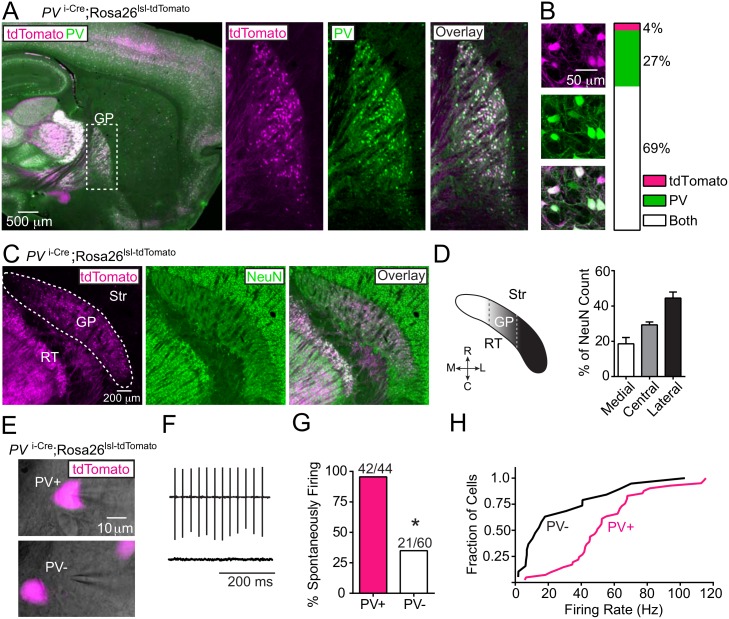
Parvalbumin (PV) expression defines a physiologically distinct cell type in the GP.(A) Left, sagittal brain section from a PV
i-Cre;Rosa26tdTomato mouse where Cre expression is reported by tdTomato (magenta) followed by immunolabeling for PV (green). Right, high magnification of boxed area containing the GP. (B) Quantification of co-localization between tdTomato (magenta) and immunolabeled PV (green) in the GP using confocal microscopy. Left, a single confocal plane. Right, summary graph of co-localization results (n = 24/679 cells tdTomato+ only; n = 184/679 cells PV+ only; n = 471/679 cells double-positive, from 2 mice). (C) Horizontal section of PV
i-Cre;Rosa26tdTomato mouse where Cre expression is reported by tdTomato (magenta) followed by immunolabeling for NeuN (green). (D) Quantification of the percentage of NeuN+ neurons with tdTomato reporter expression along the medial-lateral axis of the GP. Left, schematic of GP in the horizontal plane. Dashed lines delineate approximate groupings of medial, central and lateral sagittal sections. RT, reticular nucleus of the thalamus. Right, summary graph of mean tdTomato/NeuN percent co-localization based on sagittal sections (from 3 mice, 3 replicates/mouse). Error bars denote s.e.m. (E) Acute sagittal slice of PV
i-Cre;Rosa26tdTomato mouse brain showing cell-attached recordings from tdTomato+ and tdTomato- GP neurons. DIC image (gray) overlaid with tdTomato fluorescence (magenta). (F) Example cell-attached recordings showing action current deflections indicative of spontaneously active (top) and non-spontaneously active (bottom) GP neurons. (G) Summary graph showing the percent tdTomato+ and tdTomato- GP neurons exhibiting cell-attached spontaneous activity (n = 29/30 PV+, n = 15/41 PV- cells; from 3 mice). Asterisk, P<0.05 (Fisher’s Exact test). (H) Cumulative frequency distribution plot of firing rates from spontaneously active tdTomato+ and tdTomato- GP neurons. Active tdTomato+ exhibit faster firing rates than tdTomato- neurons (tdTomato+: meanFR = 54 Hz, medianFR = 50; TdTomato-: meanFR = 27 Hz; P < 0.05 Mann-Whitney Test).